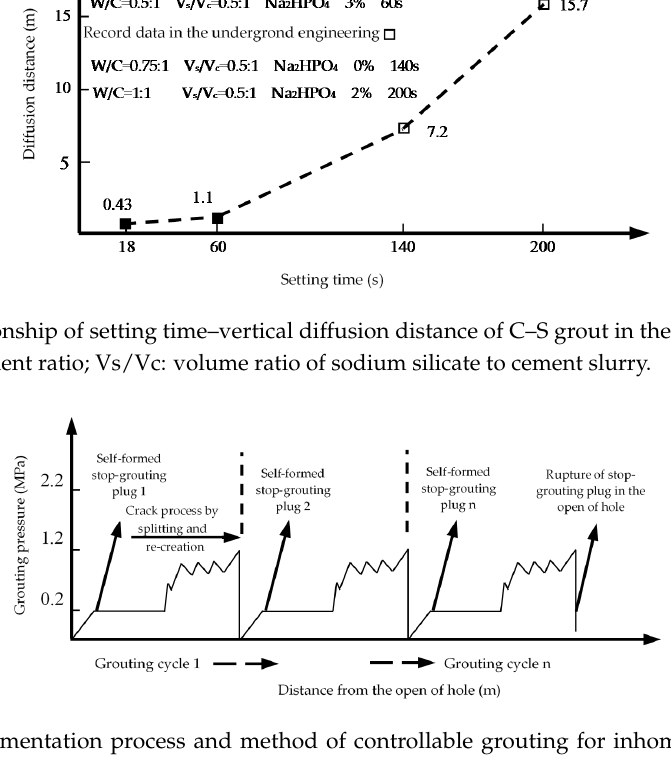
Figure 8. Implementation process and method of controllable grouting for inhomogeneous loose rock mass.